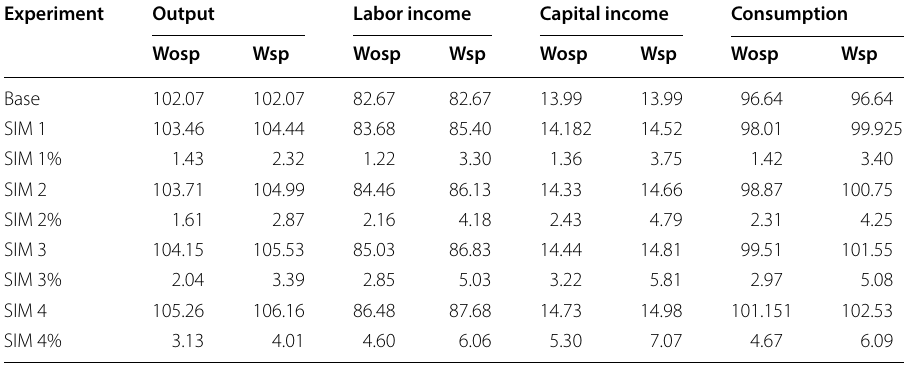
Table 2 The impacts of irrigated area expansion on output, factor income and consumption. Source: own computation result based on Oromia region